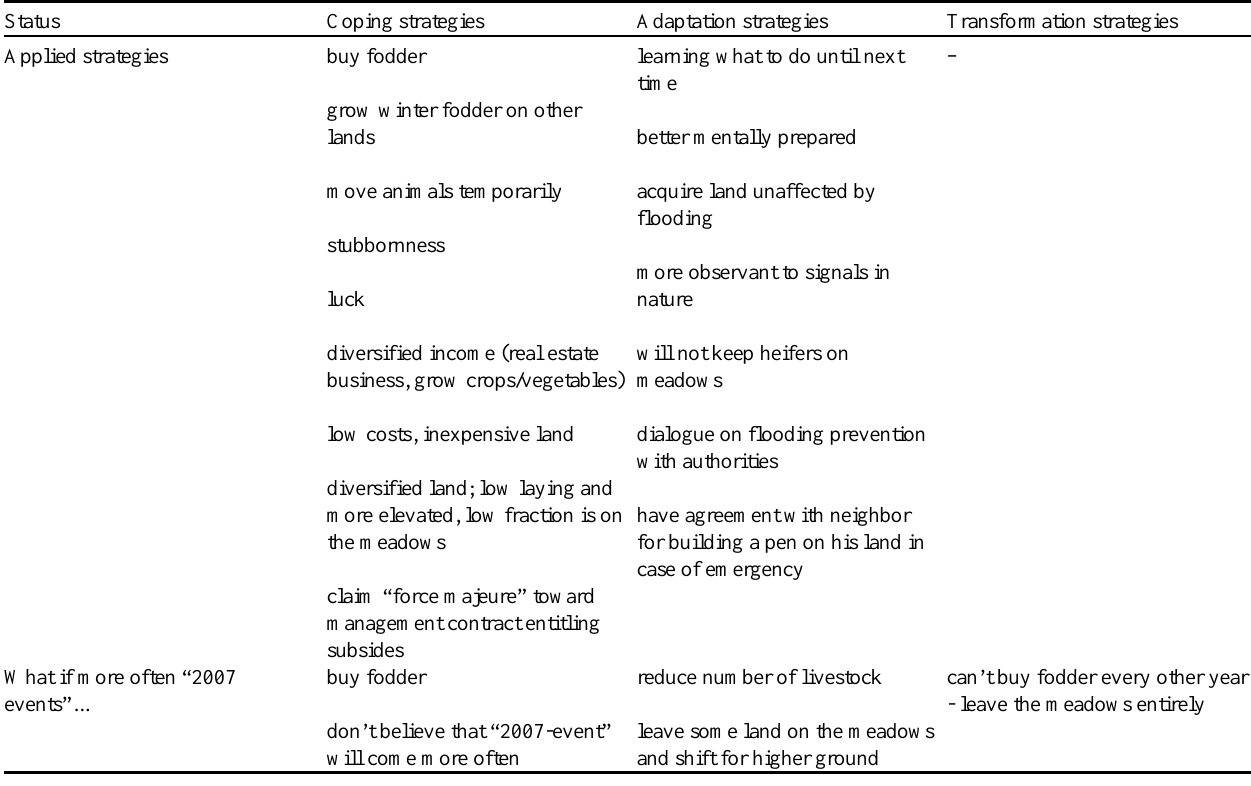
Table 3. Responses to disturbance following the flooding of 2007 according to farmers. There are nine respondents. Data was collected using semistructured interviews by telephone in